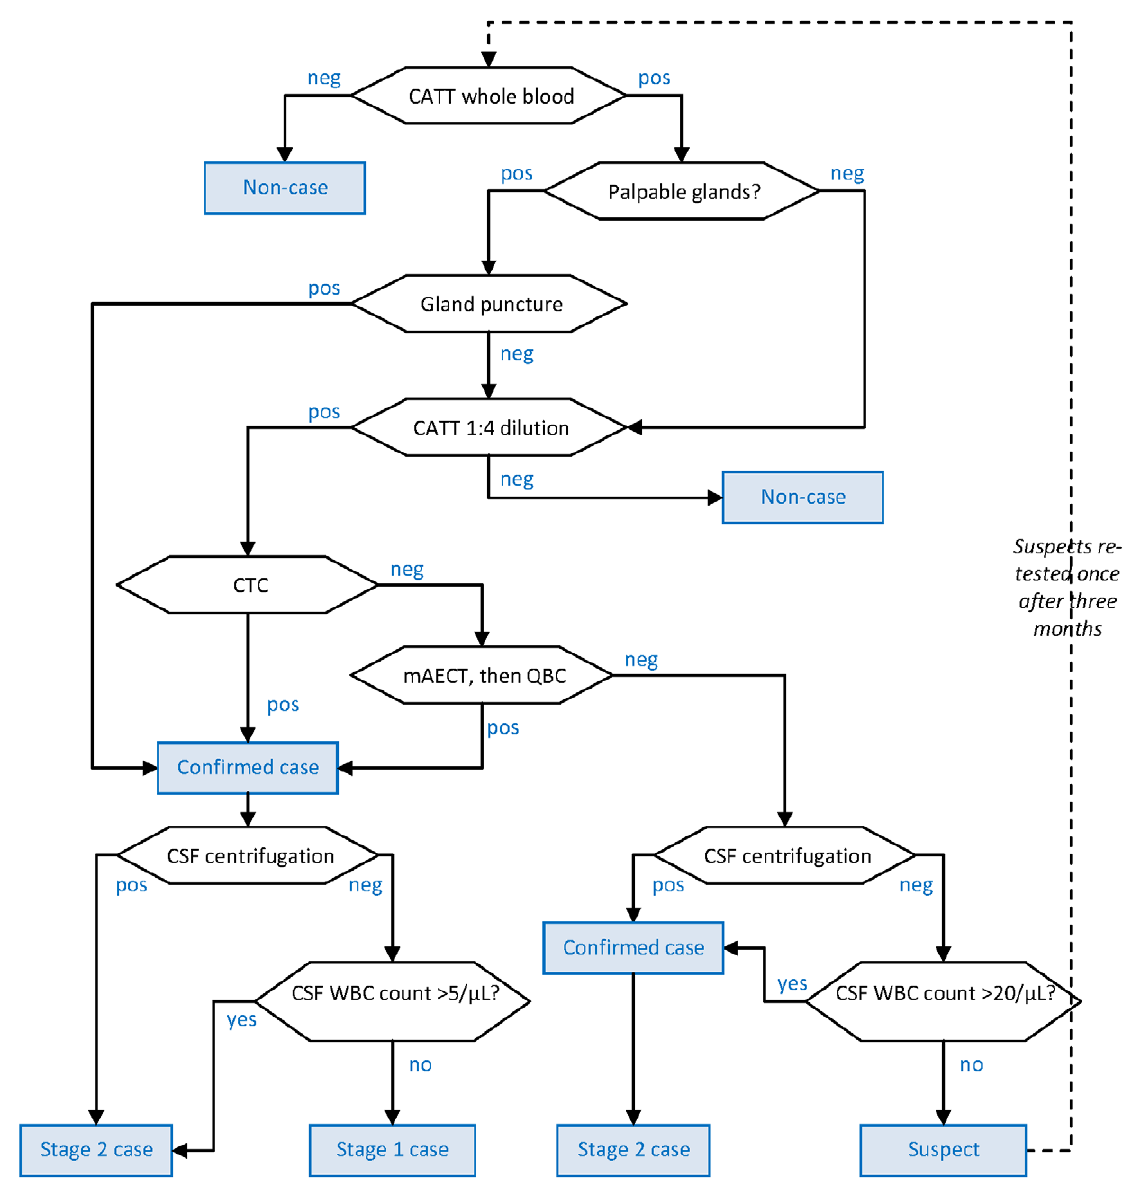
Figure 4. Diagnostic algorithm used by Adjumani programme, Uganda. Hexagonal boxes indicate tests. Square, blue-shaded boxes indicate points at which a decision on the patient is reached.